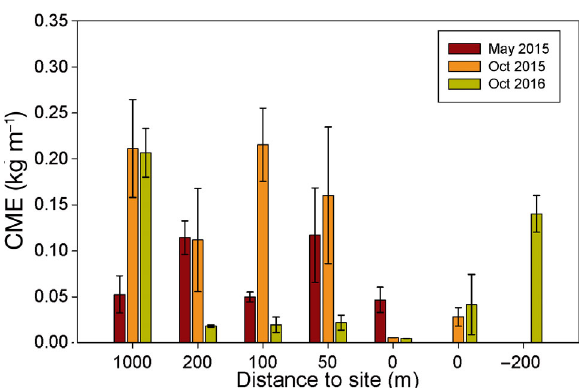
Table 3. Jordan Bay sediment characteristics, measured on 3 sampling dates. φ stot : bed solids volume fraction; fs sand: